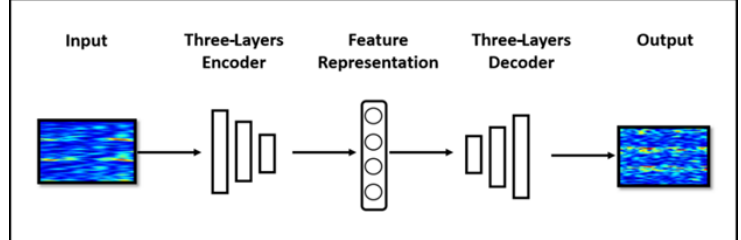
Figure 6. Data augmentation using an autoencoder.